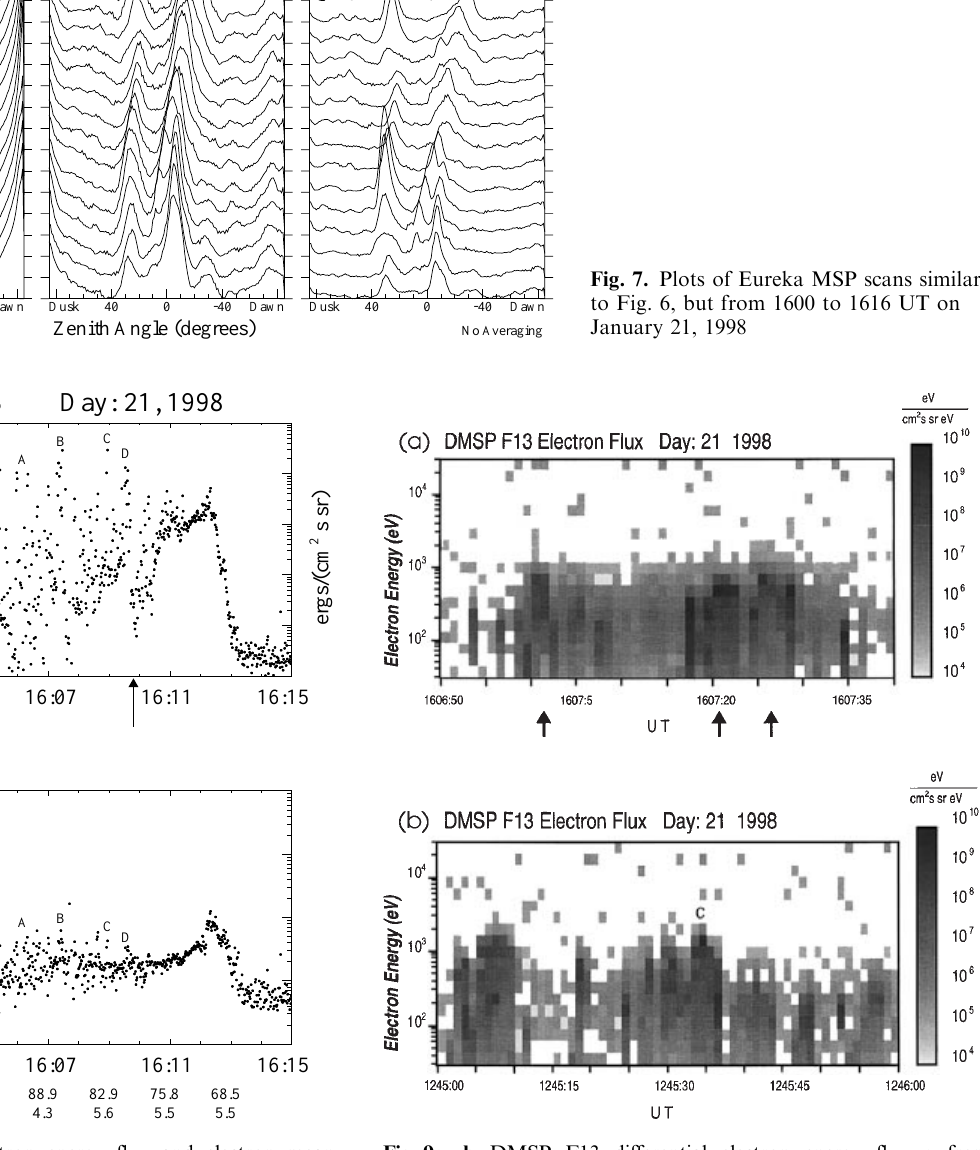
Fig. 9a, b. DMSP F13 di(cid:128)erential electron energy flux a from 1606:50 to 1607:40 UT, and b from 1245 to 1246 UT on January 21,